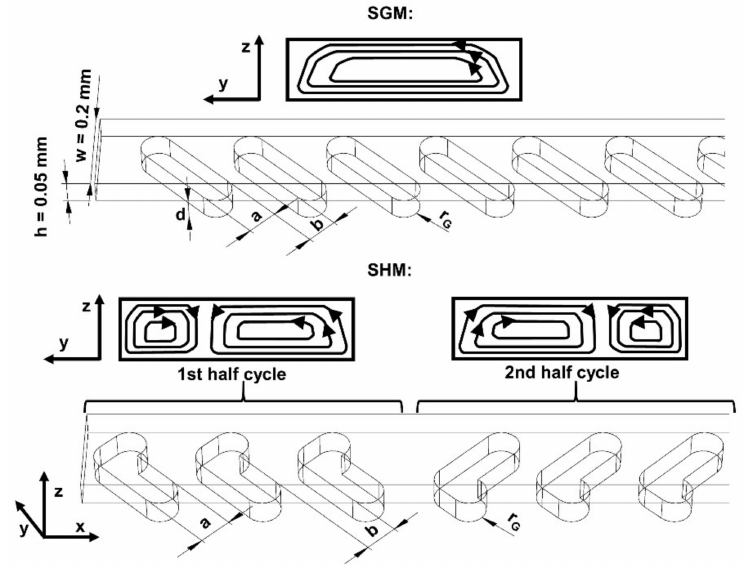
Figure 1. In the upper part, a slanted groove micromixer (SGM) geometry with schematic presentation of path lines in the channel cross-section is depicted. In the lower part, a staggered herringbone micromixer (SHM) geometry with schematic presentation of path lines in the cross-section for each half-cycle is depicted. Denotations: h —channel height, w —channel width, d— groove depth, a —groove width, b —ridge width, and r G —groove corner rounding